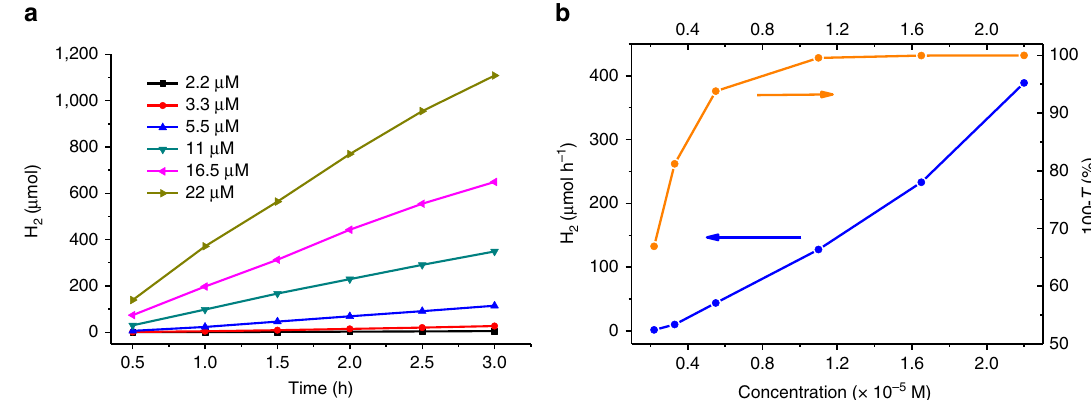
Figure 2 | H 2 evolution tests. ( a ) H 2 evolution with variable MOC-16 concentrations in DMSO solution containing 0.34M H 2 O and 0.75M TEOA. ( b ) Dependence of the photoabsorption completeness (orange, T denotes the mean transmittance) and the H 2 -production rate (blue) on the concentration of